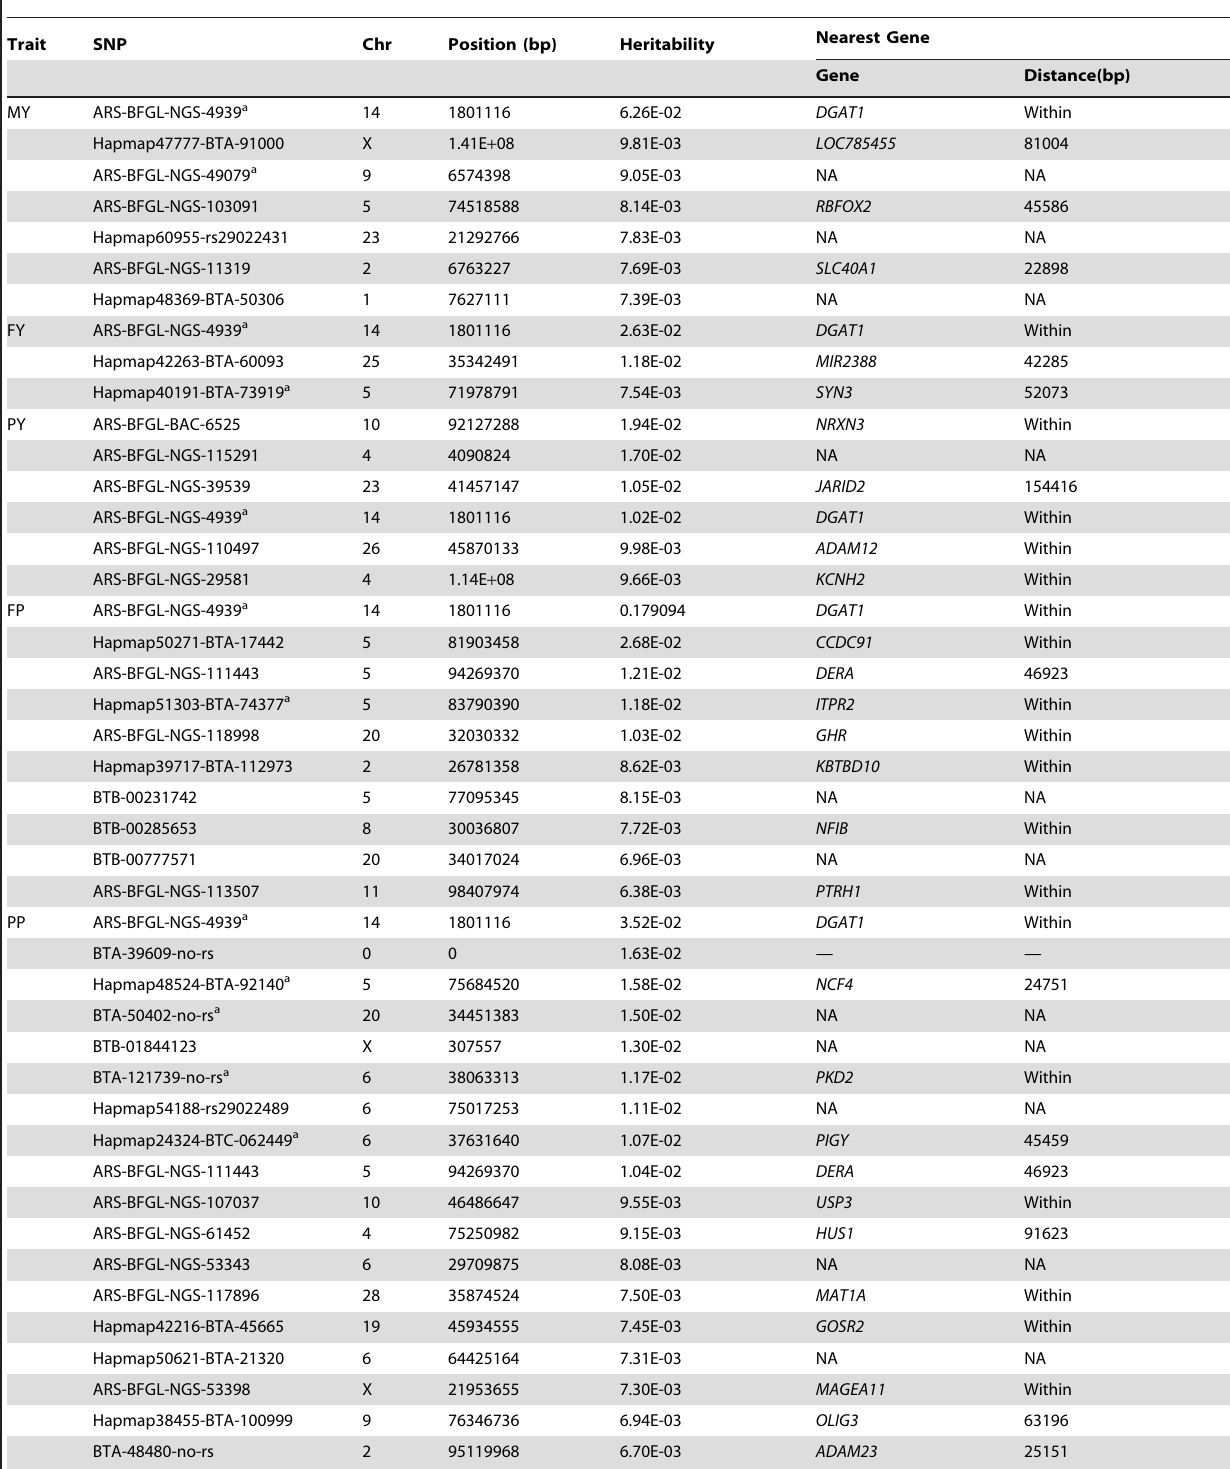
Table 1. The significant SNPs and their nearby genes in the analysis of Chinese dairy cattle data.